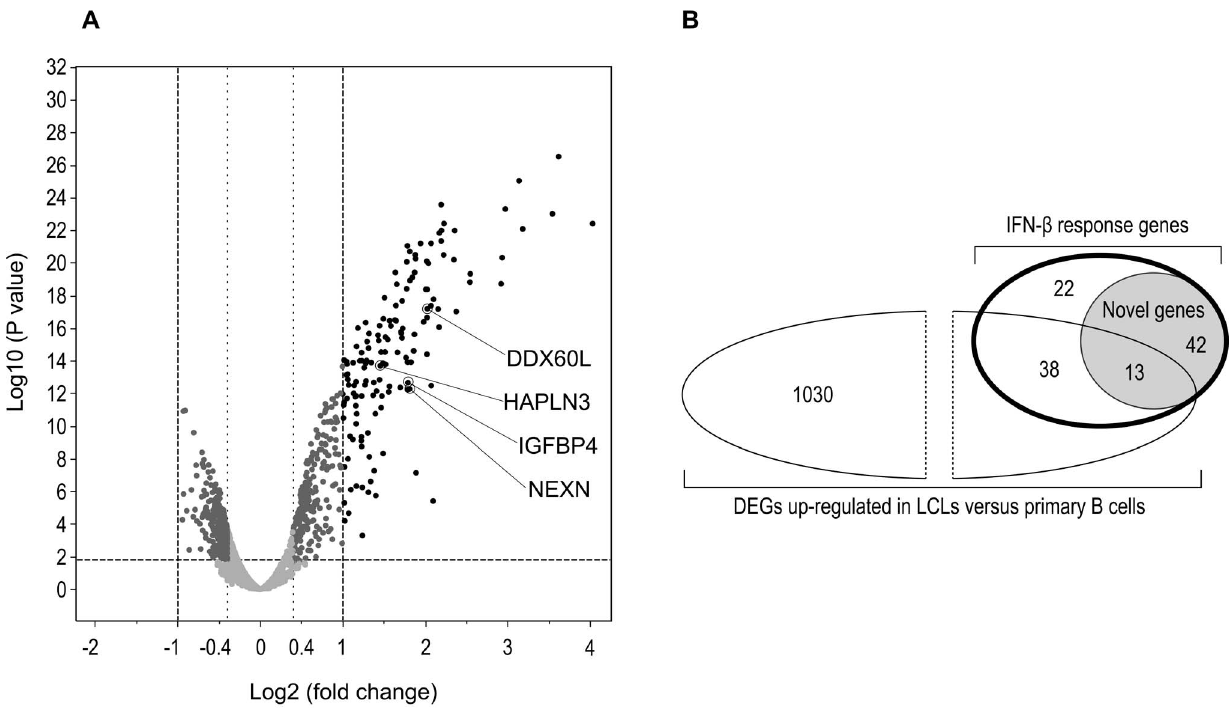
Figure 3. The LCL gene expression response to IFN- b . A: Volcano plot for the IFN- b gene expression response in LCLs. Log2(fold change) of expression levels following IFN- b exposure and P-values (one-way ANOVA) are depicted for each transcript probe. The horizontal dashed line represents the threshold for the adjusted P-value of 0.05. Vertical dashed line indicates threshold of log2(fold change) . 1 and ,2 1. Differentially expressed genes (in black) are genes with log2(fold change) $ 1 and adjusted P-value # 0.05, novel IFN- b response genes included in RTPCR validation analyses are marked. For pathways analyses a lower threshold was employed (dotted vertical line) with log2(fold change) $ 0.4 (dark grey dots). B: Venn diagram describing the proportion of differentially expressed genes in response to IFN- b [log2(fold change) $ 1, adjusted P-value , 0.05, bold outlined ellipse] that are novel response genes (grey shade), and a comparison to the published differentially expressed genes up-regulated in LCLs in comparison to primary B cells, based on the data of Caliskan and colleagues [log2(fold change) $ 1, adjusted P-value , 0.05][26]. Definition of novel IFN- b response genes is based on the Interferome V2.01 database (accessed 19.8.13) search for the 115 IFN- b response differentially expressed genes. Numbers indicate the number of genes within each subgroup.